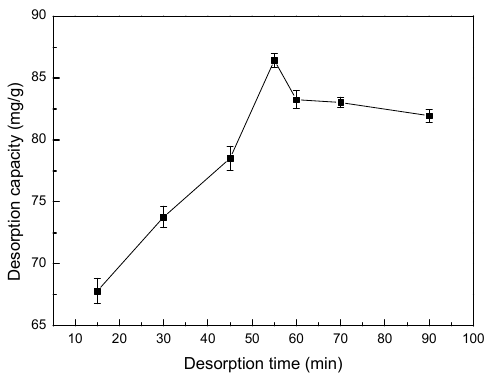
Figure 16. Effect of time on desorption capacity of LMT. Co(II)-loaded LMT nanocomposite: 0.1000 g; HNO 3 concentration: 0.5 mol/L; and temperature: 60 °C.